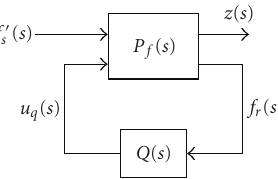
Figure 2: The LFT representation of the proposed FTCS.